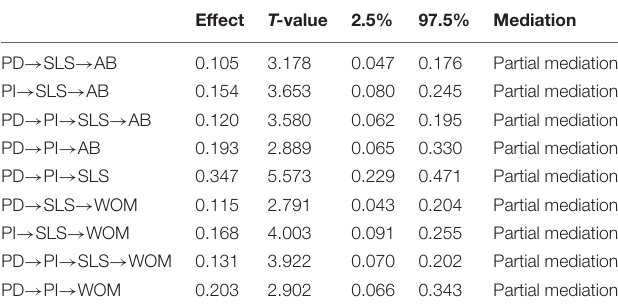
TABLE 6 | The mediation effect of place identity and life